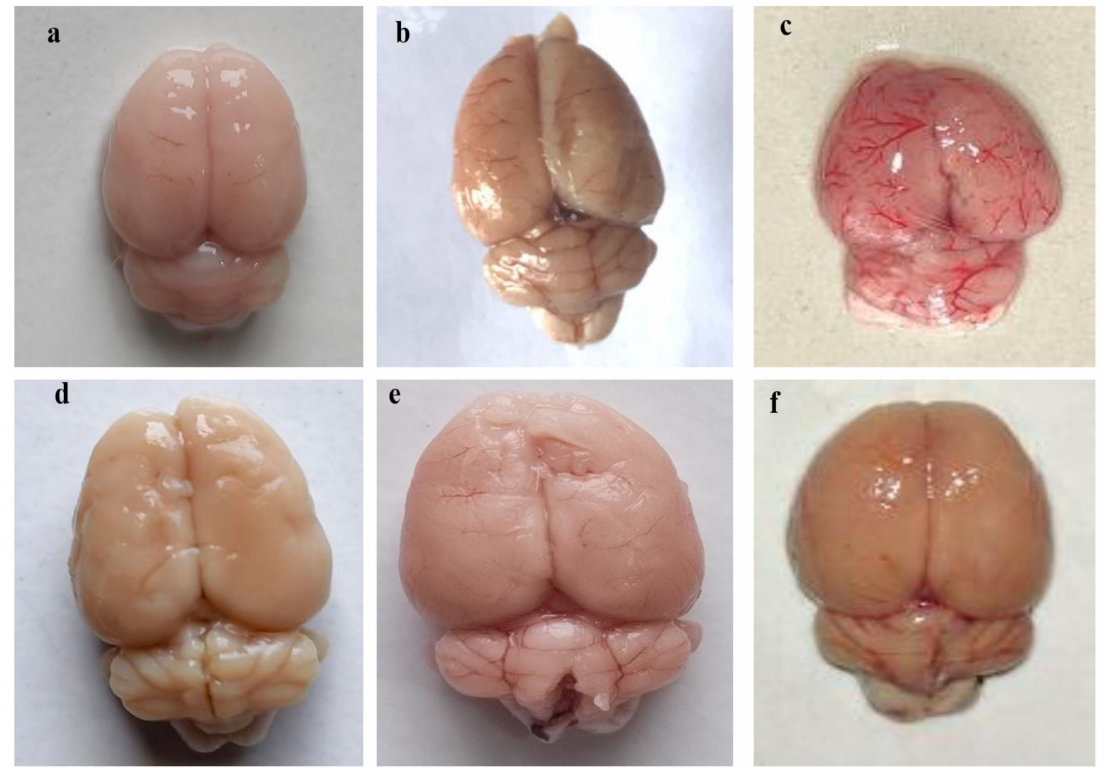
Figure 15. The effect of 4-hydroxyisoleucine on whole brain morphology in rats following methyl mercury exposure. ( a ) Normal control, ( b ) Vehicle control, ( c ) 4-HI100 perse , ( d ) MeHg5, ( e ) MeHg5 + 4-HI50, ( f ) MeHg5 +